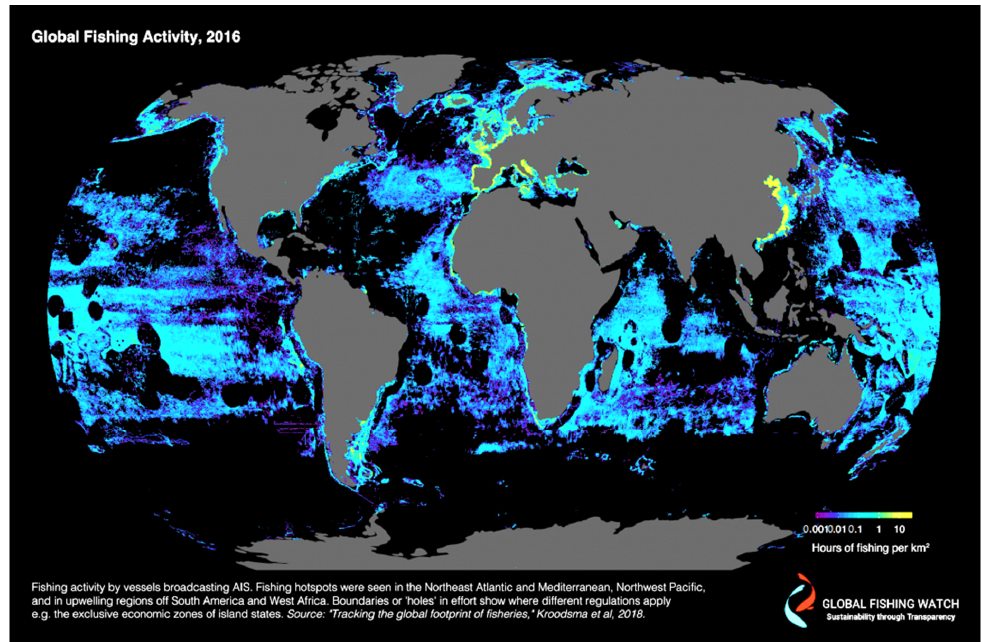
Figure 39. Fishing activity as defined by those vessels that report their positions continuously via AIS [135].